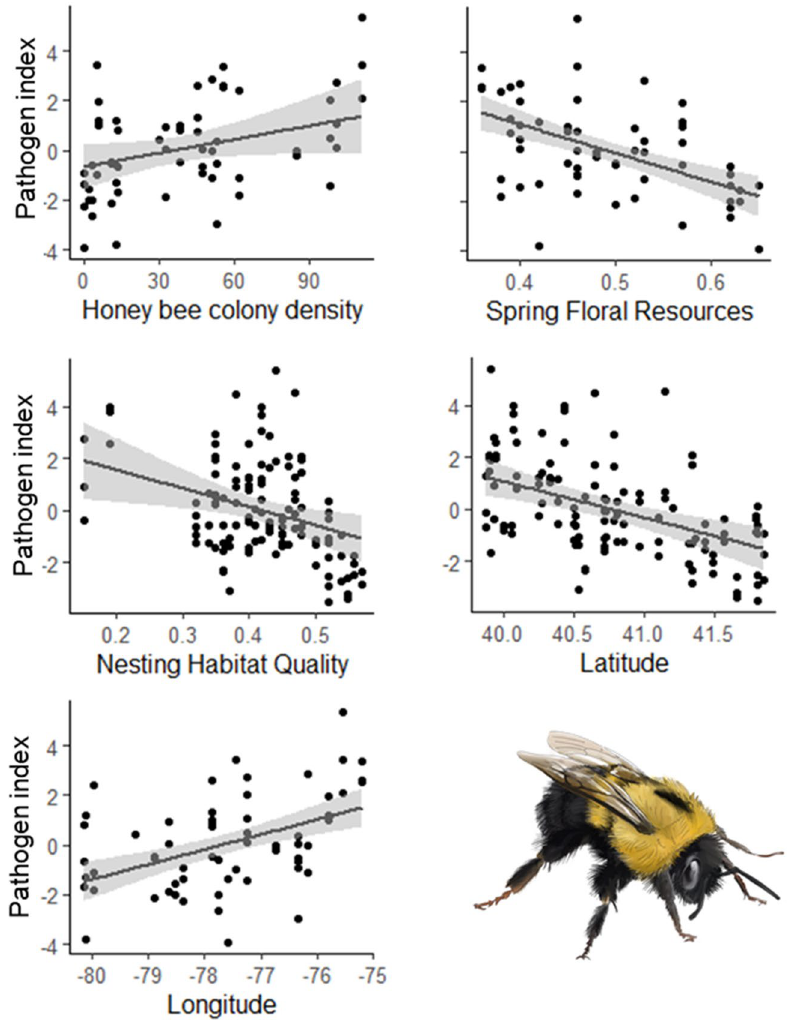
Figure 3. Functional relationships for mixed-effects regression analyses of bumble bee ( Bombus impatiens ) pathogen loads across Pennsylvania landscapes (2018–19). Shown are relationships for our ‘combined’ pathogen index (scaled) which included Vairimorpha , black queen cell virus, and deformed wing virus infection. Only patterns with statistical support based on Akaike’s Information Criterion are shown. Points on each graph indicate data points while black lines indicate model estimates and gray shaded regions are 95% confidence intervals. Pathogen loads were regressed against honey bee colony density (# colonies within 5 km; 2018; top left), spring floral resources (2018; top right), nesting habitat quality (2019; center left), latitude (2019; center right) and longitude (2018; bottom